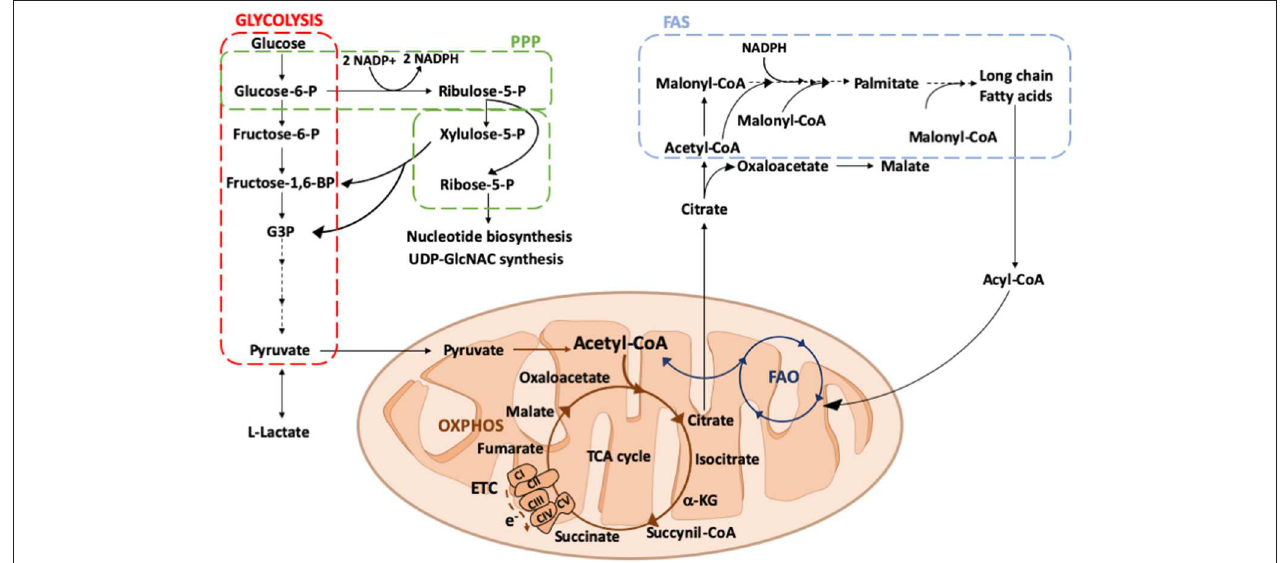
FIGURE 2 | Overview of glucose and fatty acid metabolism. Glucose is converted into pyruvate by glycolysis (red square), in the cytosol. Among the glycolytic intermediates, glucose-6P can be diverted into PPP (green square) sustaining NADPH and ribose-5P production that, in turn, are used for fatty acid or nucleotide and UDP-GlcNAC synthesis, respectively. In hypoxic conditions, pyruvate is preferentially reduced to lactate, whereas in normoxic conditions it is decarboxylated into acetyl-CoA within the mitochondria. Here, acetyl-CoA enters into the TCA cycle, providing reducing agents to the ETC to generate energy. Citrate, an intermediate of the TCA cycle, can be exported into the cytosol where it participates in fatty acid synthesis (FAS; light blue square). Fatty acids can be oxidized via FAO (dark blue square) within the mitochondrial matrix thus generating acetyl-CoA to replenish the TCA cycle. PPP, pentose phosphate pathway; ETC, electron transport chain; TCA, tricarboxylic acid; OXPHOS, oxidative phosphorylation; FAS, fatty acid synthesis; FAO, fatty acid oxidation; Glucose 6-P, glucose 6-phosphate; Fructose 6-P, fructose 6-phosphate; Fructose-1,6-BP, fructose 1-6-biphosphate; G3P, glyceraldeyde 3-phospate; Acetyl-CoA, acetyl-Coenzyme A; α -KG, alpha-ketoglutarate; e-, electrons; CI, CII, CIII, CIV, CV, complex I, II, III, IV, V; UDP-GlcNAC, Uridine diphosphate N-acetylglucosamine.